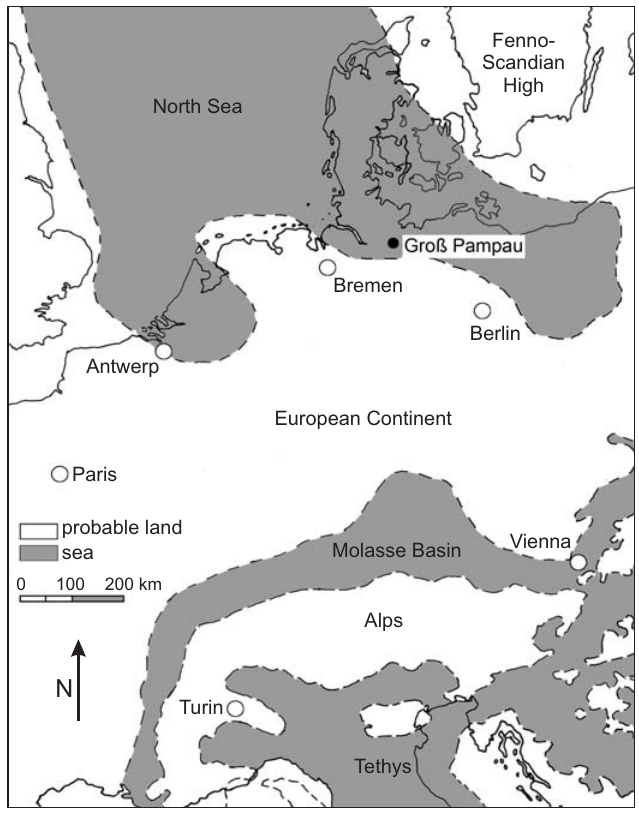
Fig. 1. Palaeogeographic map of mid-west Europe during the middle–late Miocene (compiled from Steininger et al. 1985; Huuse 2002; Rasmussen 2005) showing the locality Groß Pampau in a bay of the North Sea where the partial skeleton was